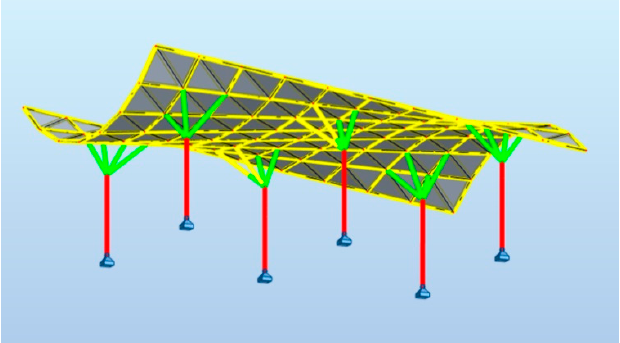
Figure 7. Maps on bars—distribution of axial force F X.